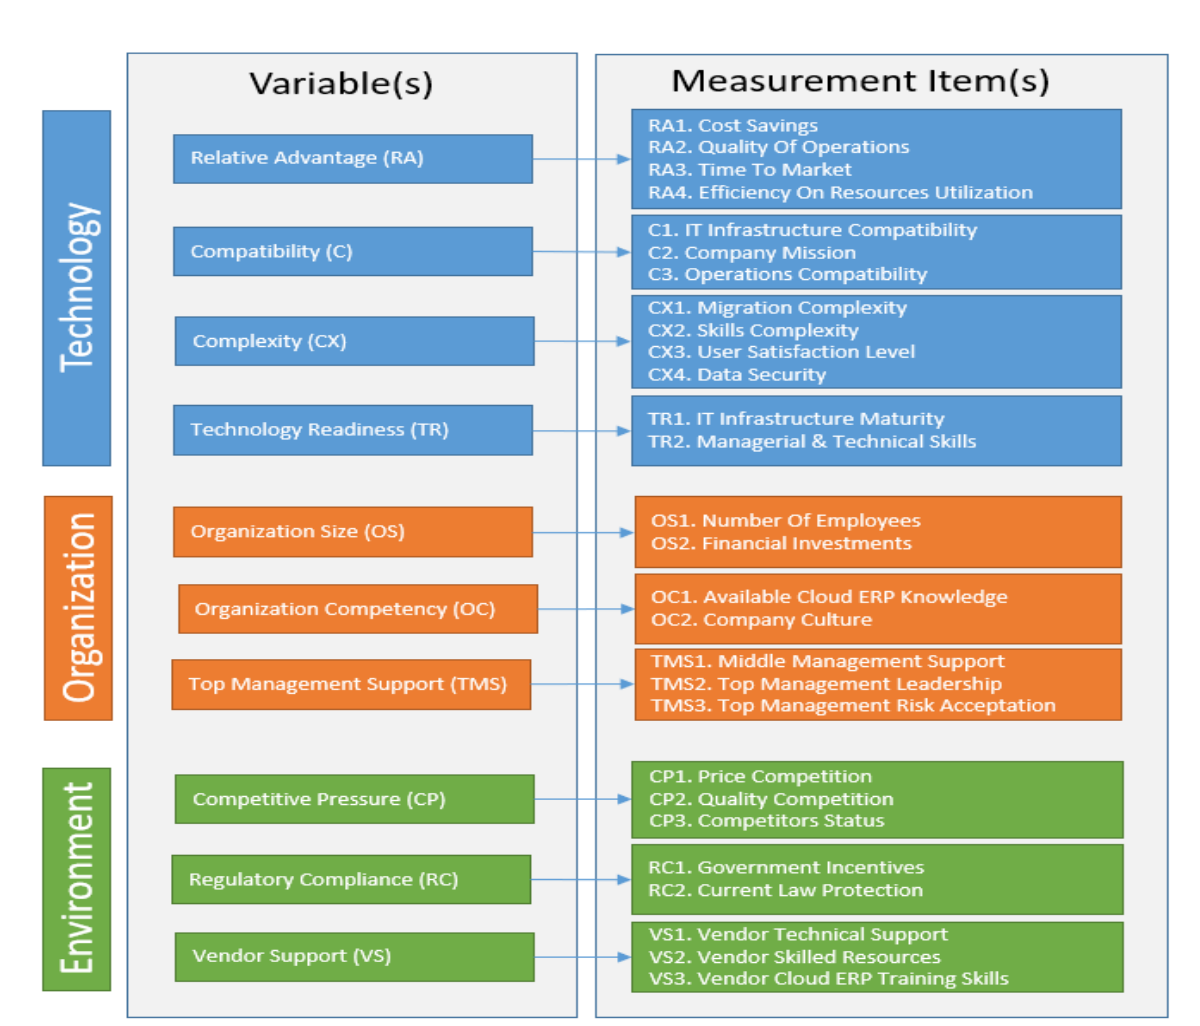
Figure 9. Measurement item.